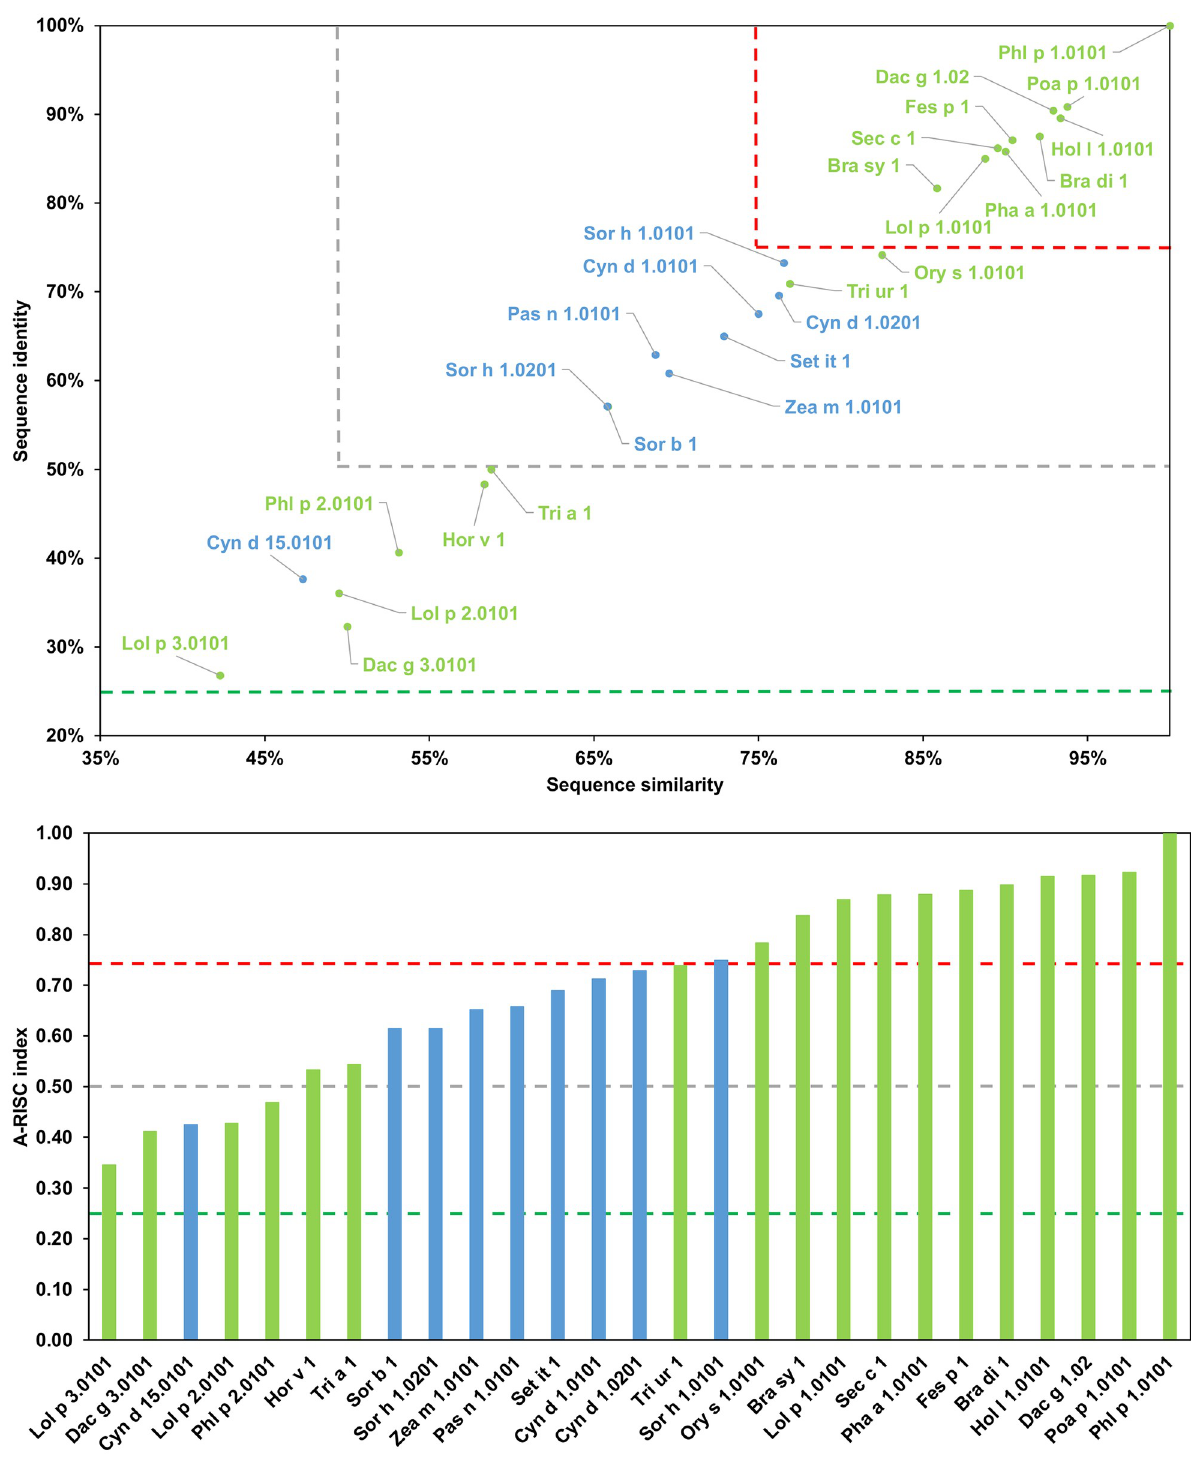
Fig 16. Plots showing relative homology and A-RISC indexes of allergens from β -expansin family of proteins. Comparison of family members to Phl p 1.0101. Temperate grasses are marked in green, while subtropical grasses are marked in blue. Red, gray and dark green dashed lines indicate respectively 75%, 50% and 25% sequence identity and similarity, or 0.75, 0.50 and 0.25 A-RISC values.